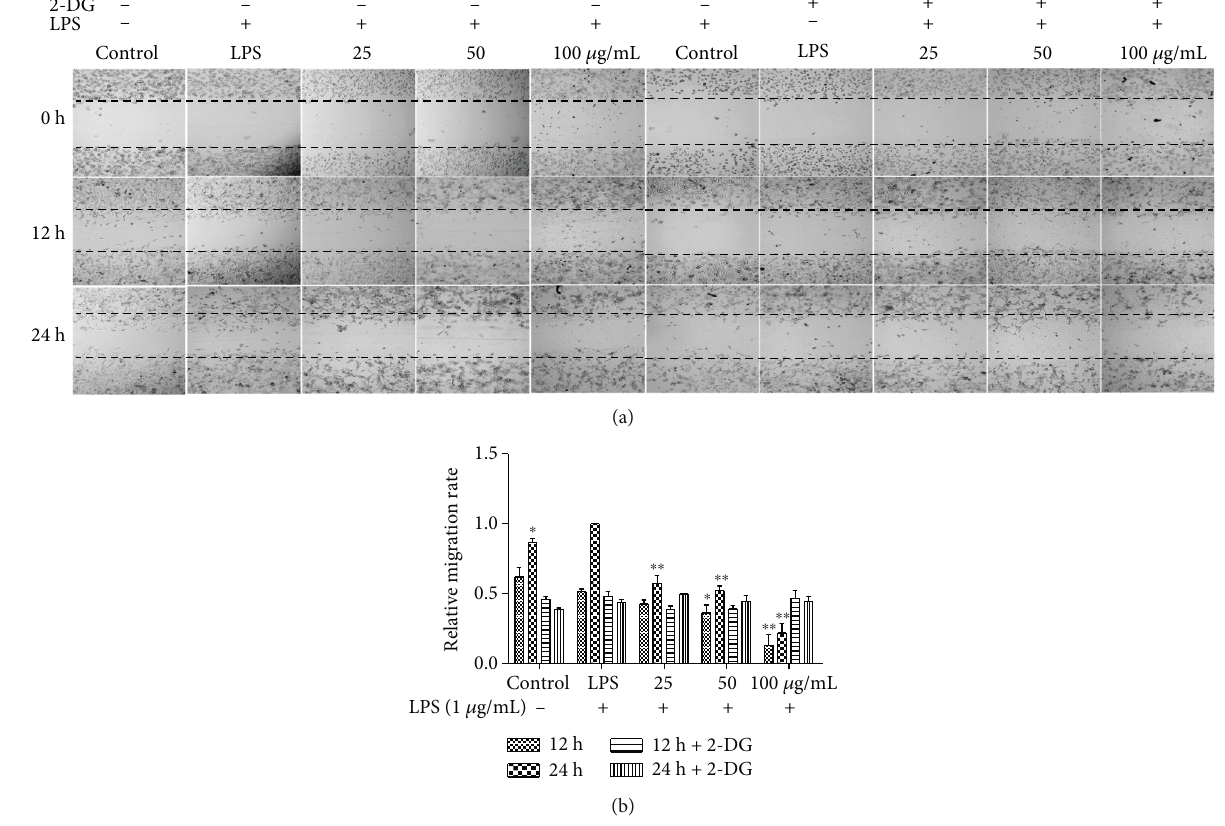
Figure 7: EECP inhibited MDA-MB-231 cell migration in a glycolysis-dependent manner. (a) E ff ect of EECP on the migration of MDA-MB- 231 cells stimulated with LPS with or without 2-deoxy-D-glucose (2-DG). (b) Quanti fi cation of the relative migration rate of MDA-MB-231 cells. Values represent the mean ± SEM from three independent experiments ( ∗ P < 0 : 05 , ∗∗ P < 0 : 01 vs. control, n = 3